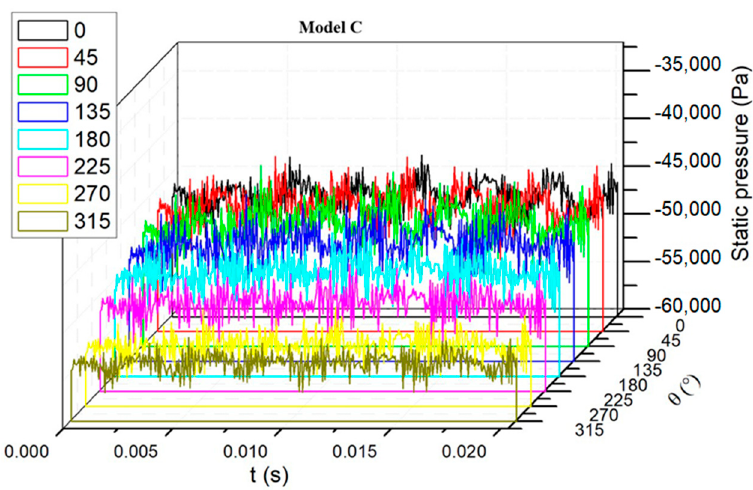
Figure 8. Pressure fluctuation at the circumferential positions against the time domain.